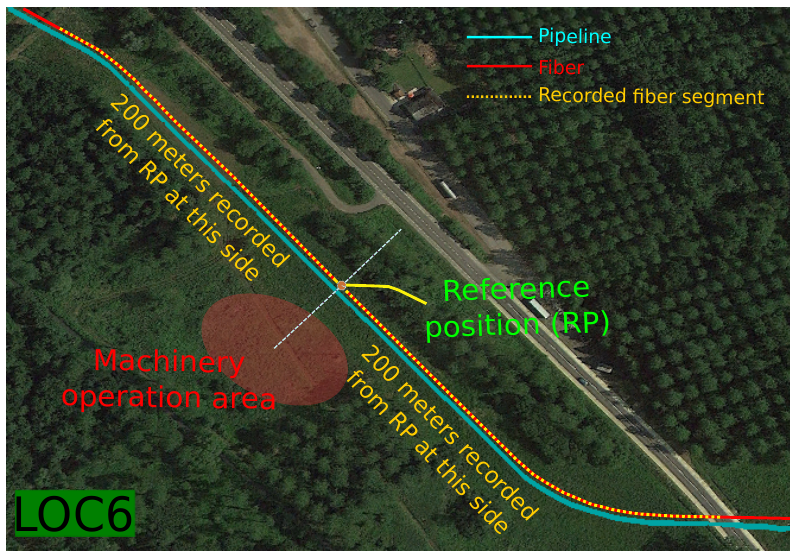
Figure 3. Location 6 (LOC6) recording scenario, reproduced with permission from [26]. RP stands for “reference point”, referring to the center of the machine operation area. Table 1. Recording location details (slightly modified with permission from [26]).